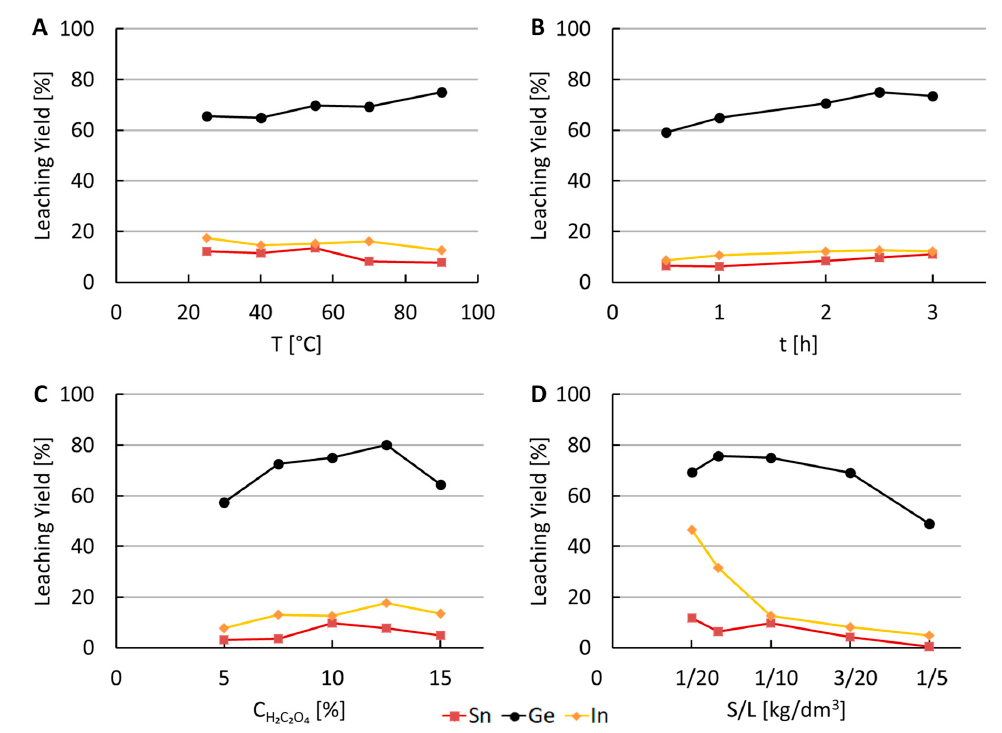
Figure 5. Leachabilities of tin, germanium and indium in oxalic acid solution. Influence of: ( A ) temperature (t = 2.5 h, C H ₂ C ₂ O ₄ = 1 M, S/L = 1/10); ( B ) time (T = 90 °C, C H ₂ SO ₄ = 1 M, S/L = 1/10); ( C ) H 2 C 2 O 4 concentration (T = 90 °C, t = 2.5 h, S/L = 1/10); ( D ) S/L ratio (T = 90 °C, t = 2.5 h C H ₂ C ₂ O ₄ = 1 M).